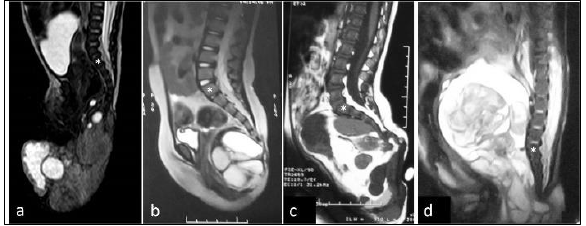
Figure 4: Pure cystic type of SCT (C1). a) Three-day-old female presenting with a cystic mass at the lower back, initially misdi- agnosed as meningeocele. (b,c,and d) Sequential sagittal T2WIs, showing the deep extension and the multi-cystic nature of the mass. b) The pre-sacral cystic lesion is sending out-pouching through the neural foraminae (curved black arrow) into the spi- nal canal. c) Demonstration of the intra-spinal extension of the mass (straight black arrow). d) Mid-sagittal plane demonstrat- ing the normal termination of the spinal cord (white arrow), with intact vertebral bodies down to the coccyx. Note the vagi- nal distension (*) and bladder compression by the mass effect of the